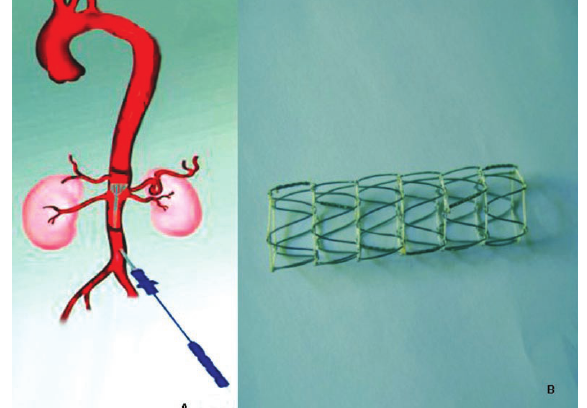
Fig. 2 – A. Esquema representativo de introdução e liberação do stent, mostrando liberação do stent em frente às artérias renais. B. Stent descoberto